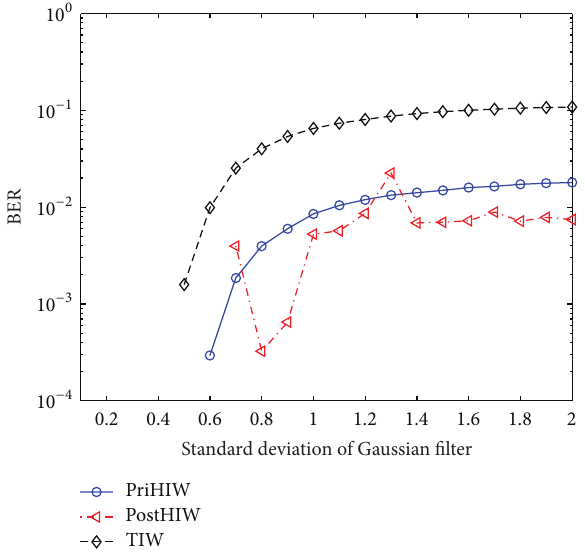
Figure 11: Performance comparison for the PriHIW, PostHIW, and TIW against the